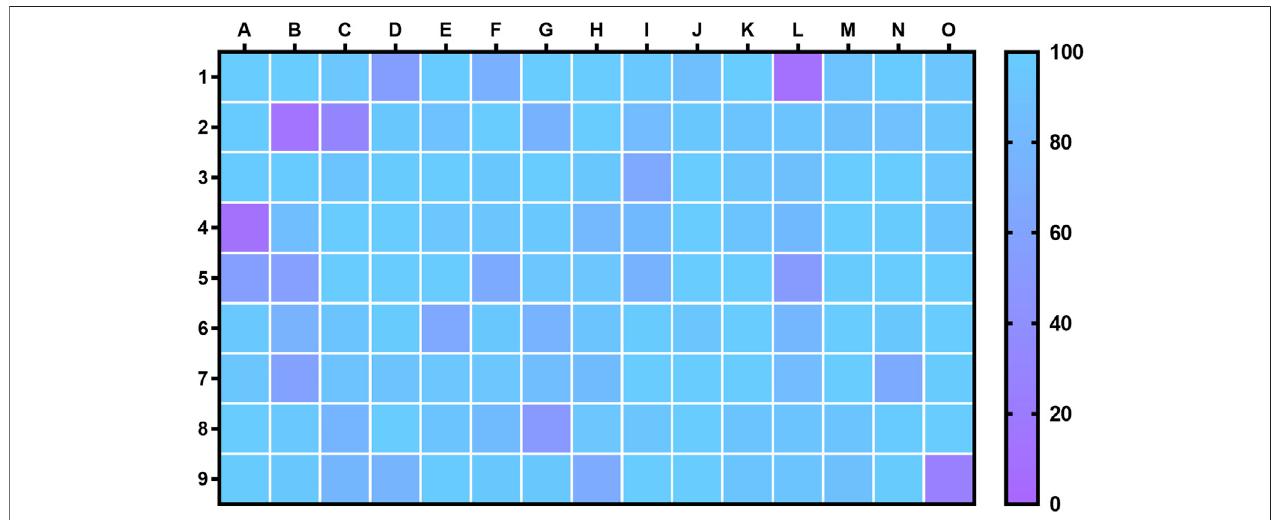
FIGURE 2| Impact of alibrary of natural products on MRC-5 fi broblastsviability, asdetermined by MTT reduction assays. Resultsrepresent the percentage of the control and correspond to, at least, three independent experiments, each performed in